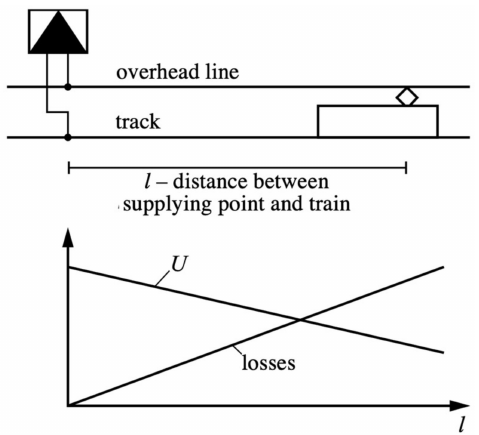
Figure 1. Changing overhead contact line voltage as a function of distance from the power sup- ply